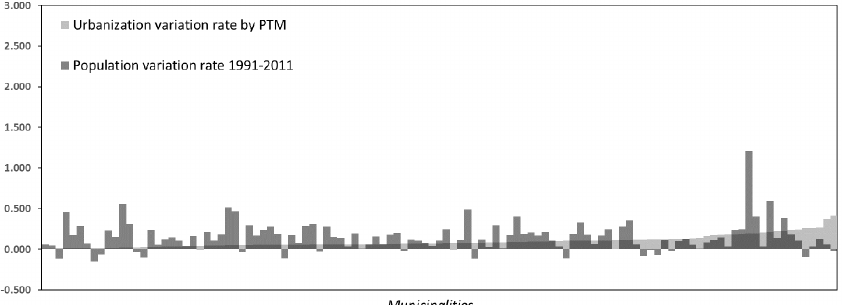
Figure 6. Demographic dynamics for the period 1991–2011 compared to the rate of urban increase per individual municipality according to their planning tools inserted in the Lombardy region PTM. (Municipalities with Urban Density (UD) >50%).